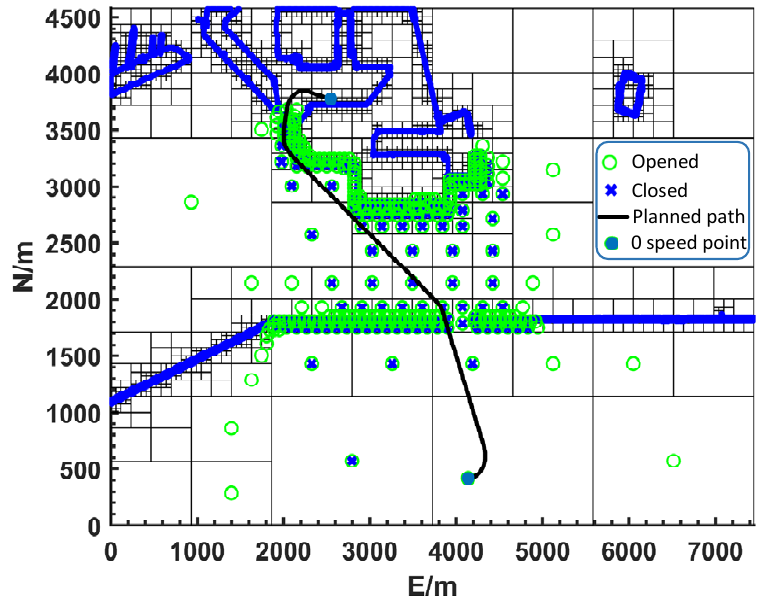
Figure 8. Path planned through multi-scale A* algorithm with RSC.